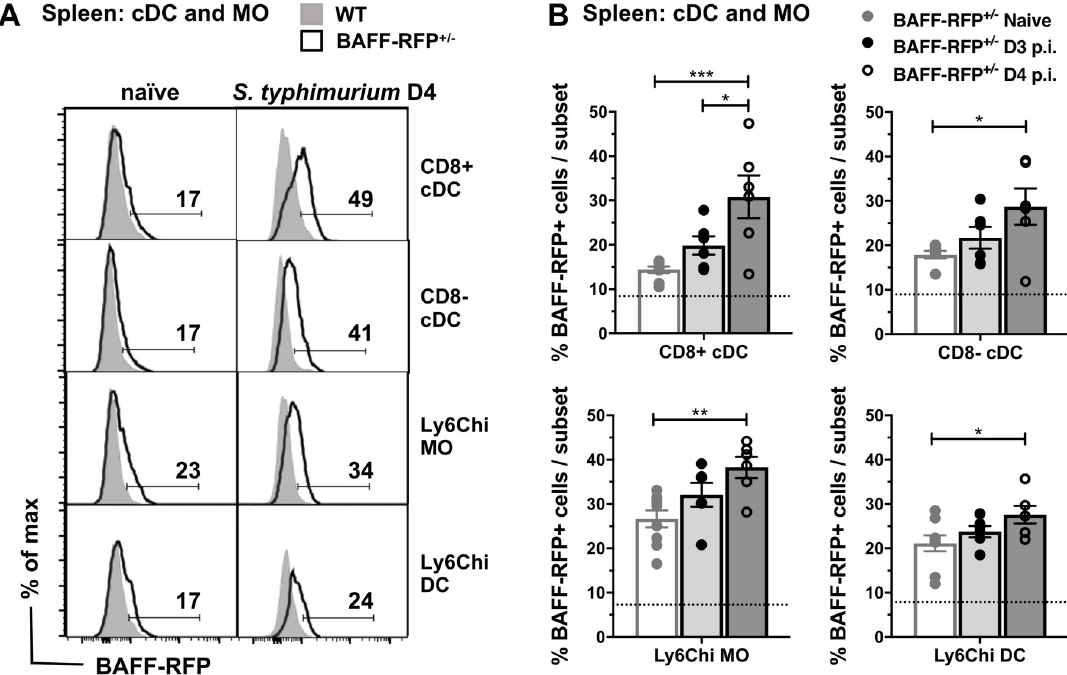
Fig 2. Upregulation of BAFF-RFP in cDC and MO myeloid subsets after S . typhimurium infection. WT and BAFF-RFP +/- mice were infected i.p. with 500 CFU S . typhimurium and BAFF-RFP + cell populations from na ï ve, day 3 and day 4 infected spleens were analyzed by flow cytometry. (A) BAFF-RFP expression from cDC subsets (CD8 + cDC and CD8 - cDC) and MO subsets (Ly6C hi MO and Ly6C hi DC) from na ï ve and day 4 S . typhimurium infected mice are shown as representative histograms from three independent experiments. Numbers in the plots indicate the percentage of BAFF-RFP + cells. (B) Bar graphs (means ± SEM) indicate the percentage of BAFF-RFP + cells and dotted lines show the percentage of RFP background signal in WT cells. Data are combined from three independent experiments (n = 6–9). Statistics were determined with one-way ANOVA with Holm–Sidak method for multiple comparisons test. � p < 0.05, �� p < 0.01, ��� p <